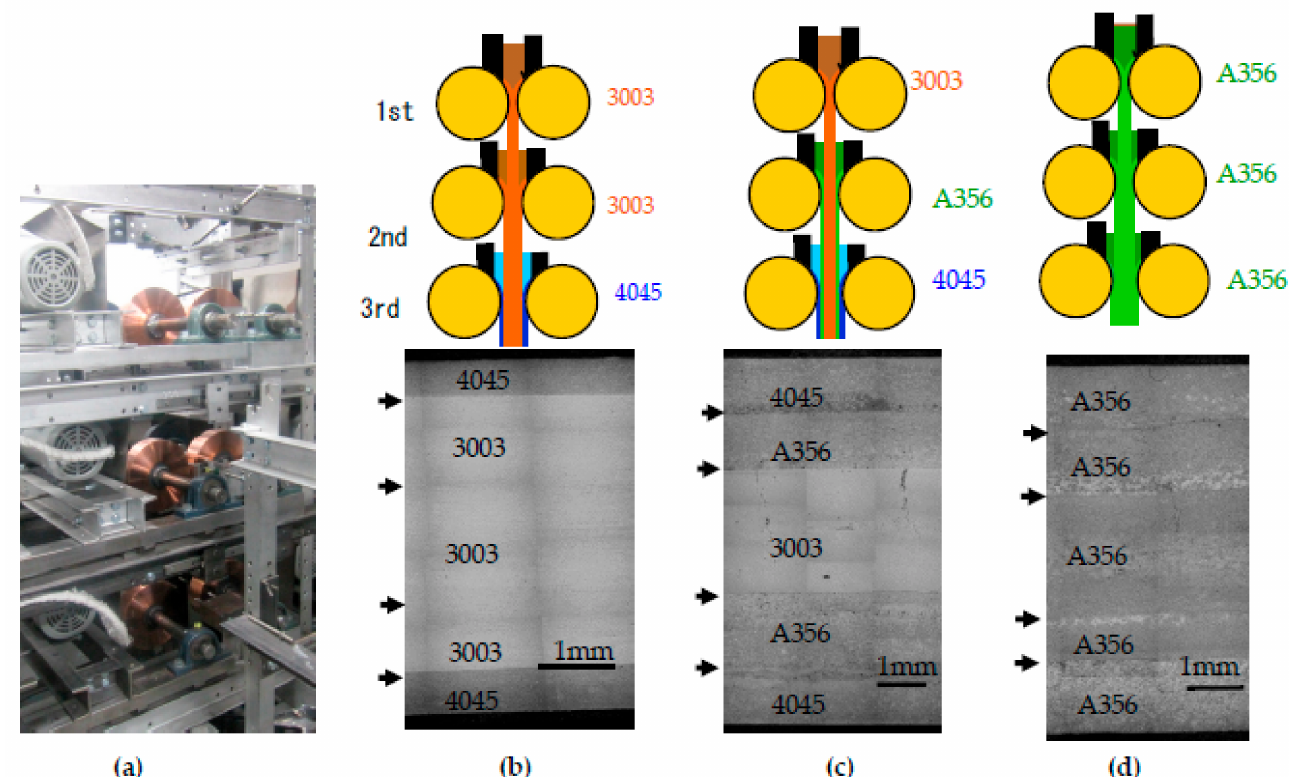
Figure 18. Photograph and schematic illustrations of vertical-type tandem twin roll casters to cast five-layer clad strips, and cross-sections of the five-layer clad strips. Arrows show the interfaces between the strips. ( a ) Photograph of rolls of a triple tandem-type twin roll caster. ( b ) The same alloy was used in the 1st and 2nd twin roll casters. ( c ) Different alloys used in each twin roll caster. ( d ) The same alloy was used in the 1st, 2nd, and 3rd twin roll